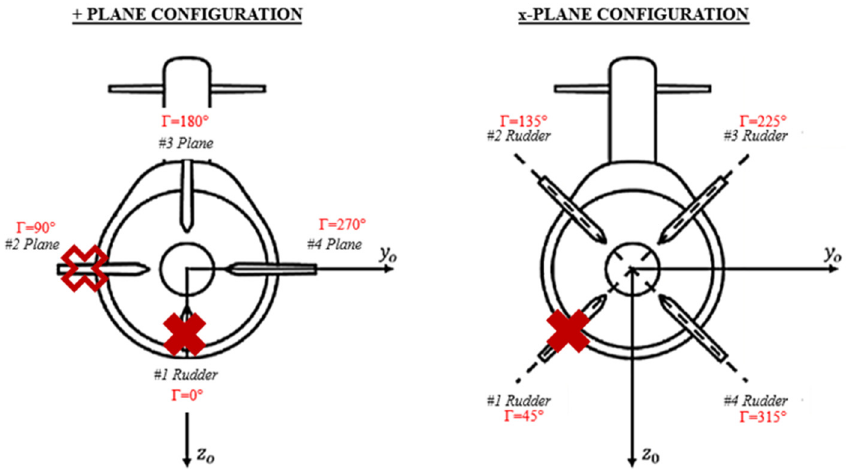
Figure 16. Stern-plane failures.